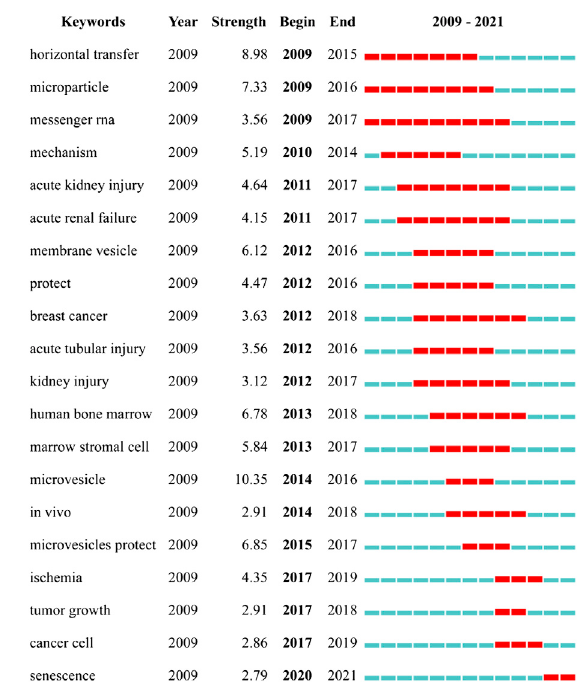
Frontiers in Bioengineering and Biotechnology |